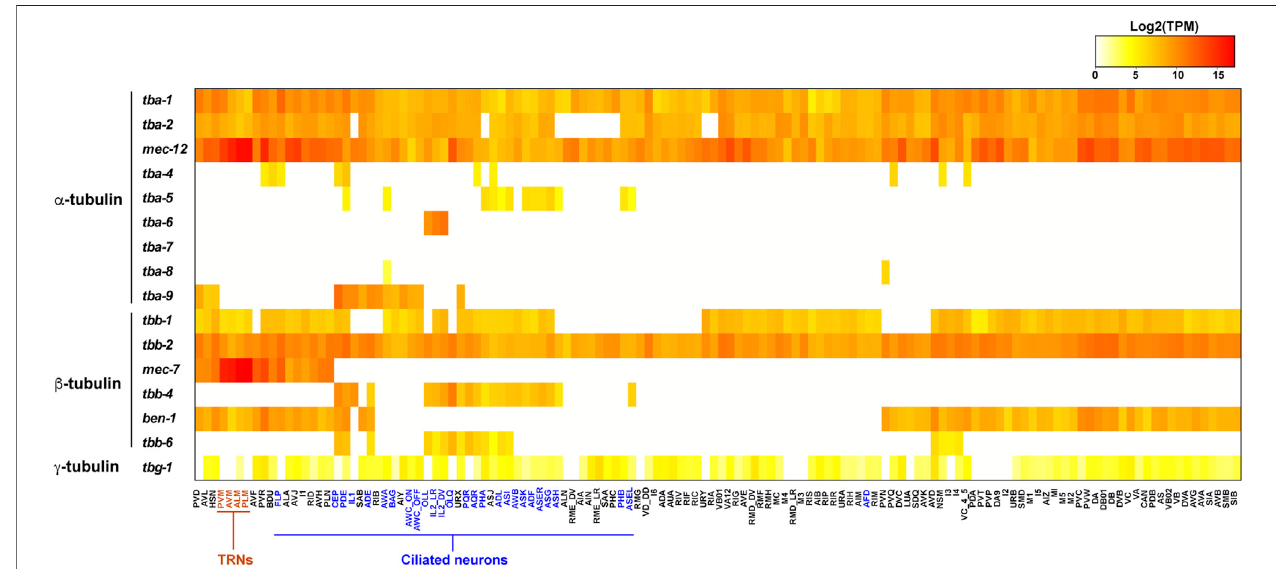
FIGURE 2 | Heatmap for the expression of tubulin isotypes in the C. elegans nervous system. Transcript levels (TPM) of tubulin isotypes in each neuron type were extracted from the scRNA-seq data (Taylor et al., 2021) and log2 transformed. TRNs are in red and ciliated neurons are in blue. Raw data can be found in Supplementary Table S1